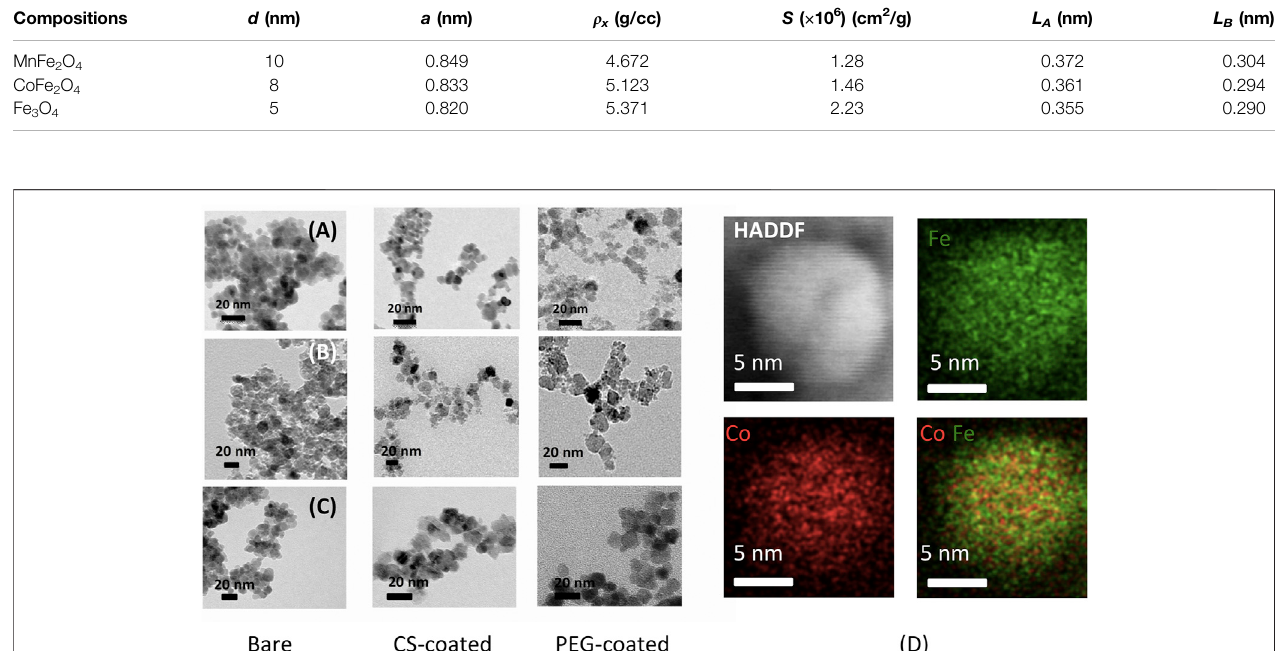
FIGURE2| TEMimagesofMnFe 2 O 4 ,CoFe 2 O 4 ,andFe 3 O 4 withforthe (A) barenanoparticles, (B) chitosan-coated, (C) PEG-coatednanoparticles,and (D) STEM EDS mapping of chitosan-coated CoFe 2 O 4 nanoparticle.